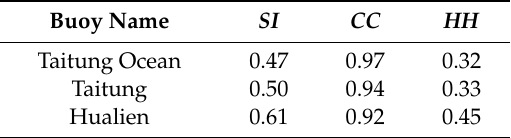
Table 2. Statistical parameters of SWH based on model-data comparison for di ff erent buoys using winds from CFSV2_0.205D_1hr_H2.